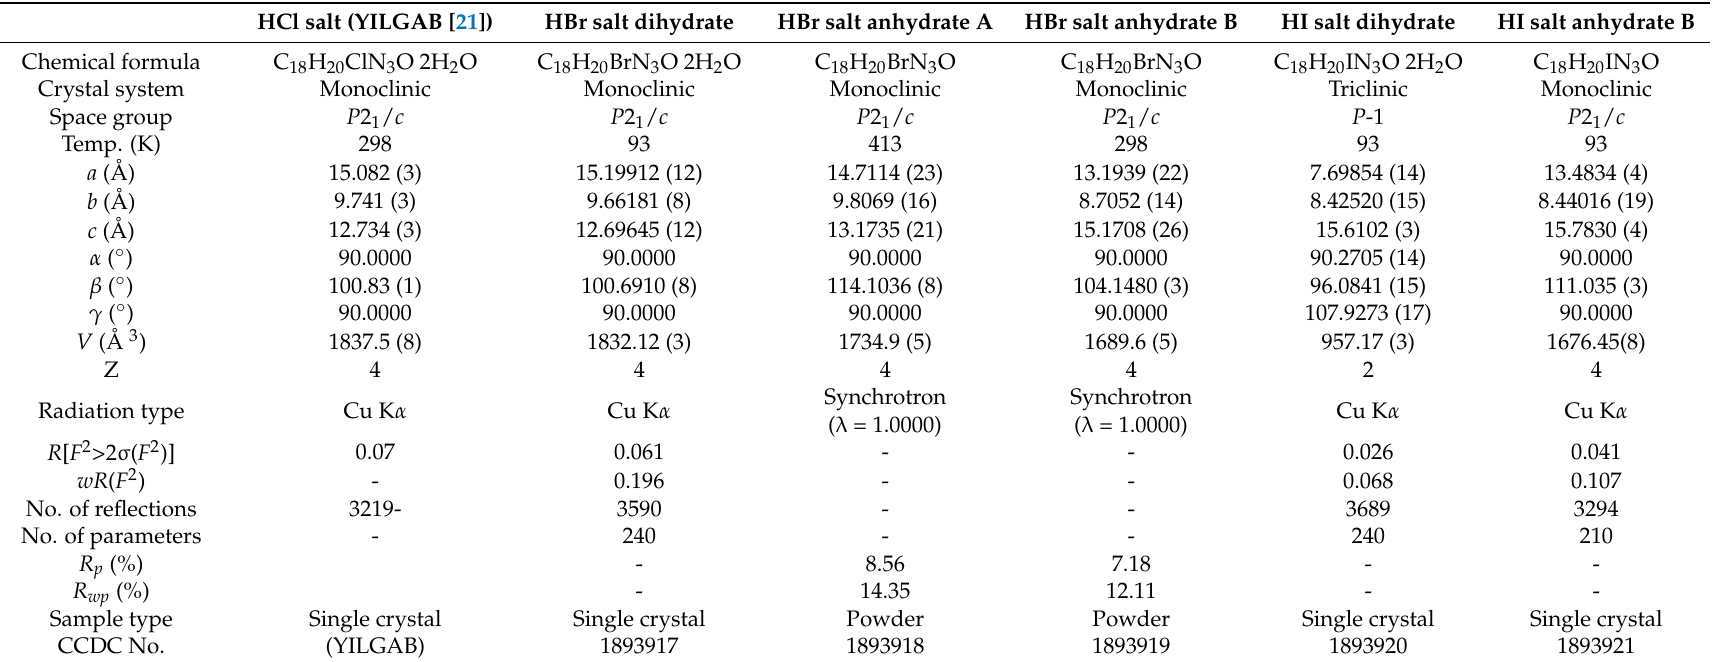
Table 1. Crystal graphic parameters of the ondansetron HCl salt, HBr salt and HI